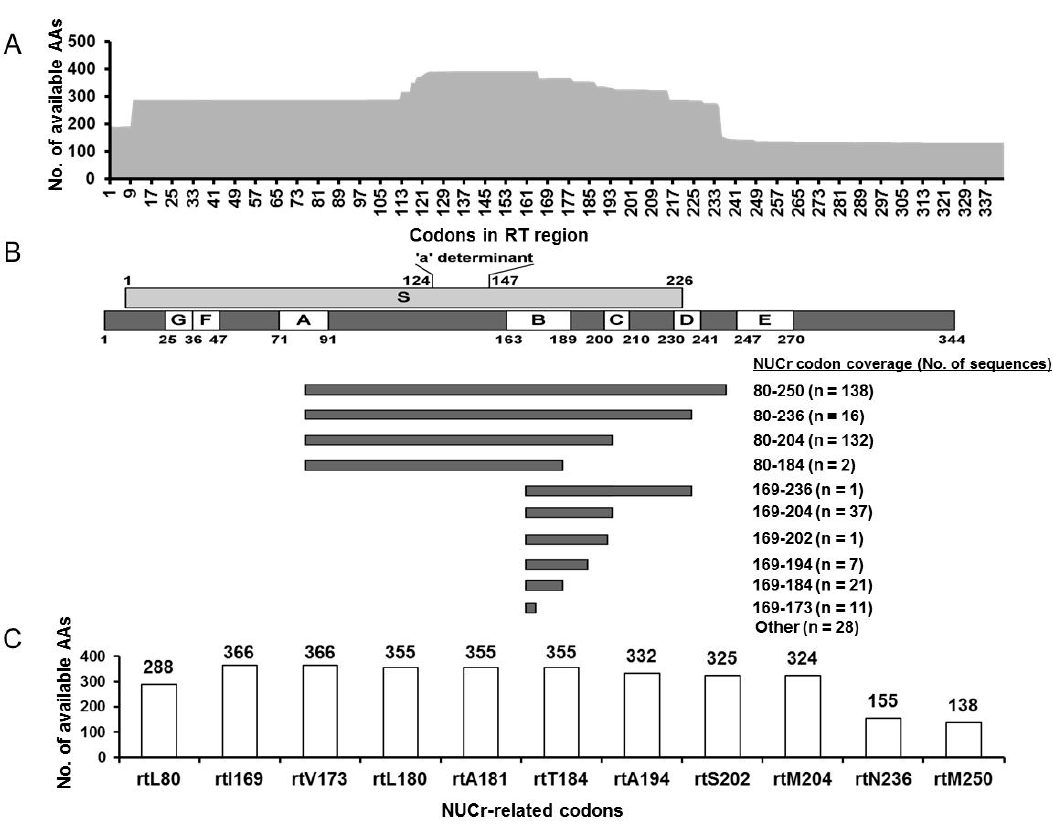
Figure 2. Schematic illustration of the analyzed RT sequences. ( A ) The total number of available AAs at each codon in 394 HBV RT sequences; ( B ) All sequences are clustered based on the different coverage of analyzed NUCr-related codons. For example, “80–250” shows where these sequences include 11 studied NUCr-related codons. “Other” shows where no NUCr-related codons are covered by these sequences; ( C ) The number of available AAs for each of the NUCr-related codons studied is summarized. AA: amino acid; HBV: hepatitis B virus; NUCr: nucleos(t)ide analogue resistance; RT: reverse transcriptase.